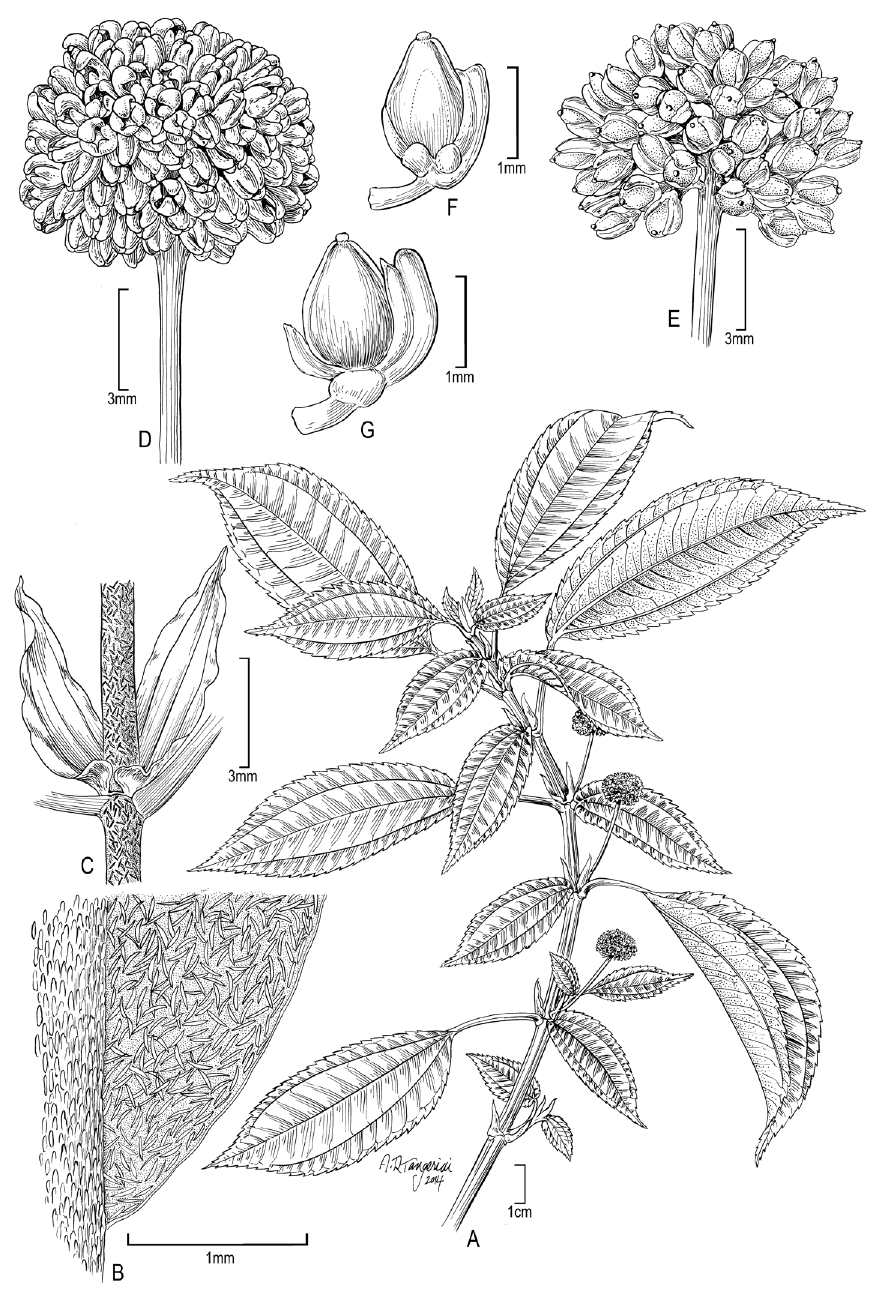
Figure 4. Pilea nidiae . A Habit; note the unequal leaf laminae at each node B Leaf detail (major lamina upper surface) showing cystoliths C Stipules and stem covered with cystoliths D Staminate inflorescence E Infructescence F , G Pistillate flowers with developing achenes. ( A , D from J.L. Luteyn & E. Cotton 9705 (NY); B , C from J.A. Steyermark 55533 (US); E – G from B. Stergios & R. Caracas 19810